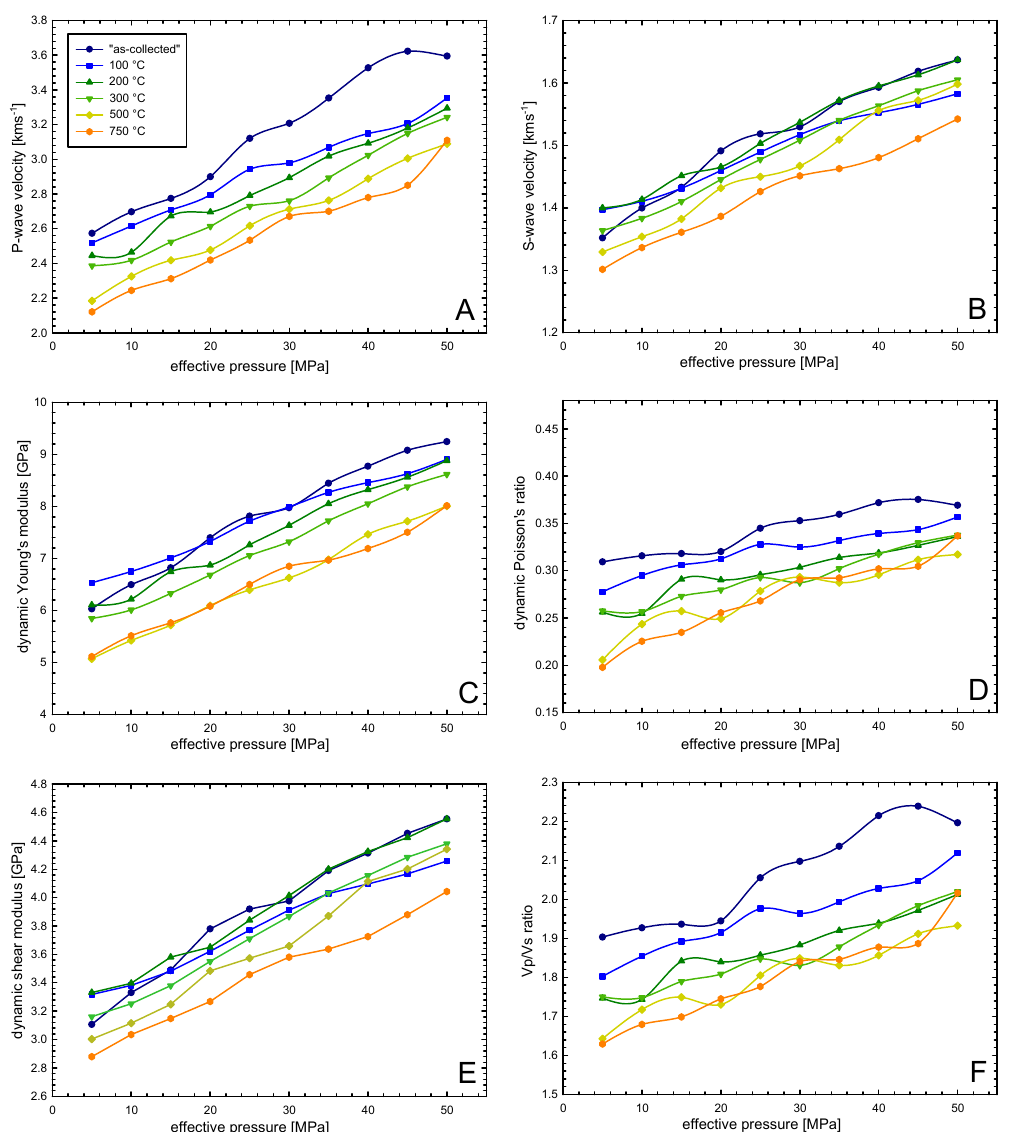
Fig. 7. The evolution of P wave velocity (A) , S wave velocity (B) , dynamic Young’s modulus (C) , dynamic Poisson’s ratio (D) , dynamic shear modulus (E) , and V P /V S ratio (F) with increasing effective pressure for Neapolitan Yellow Tuff. The temperatures in the legend refer to the thermal stressing temperature (see text for